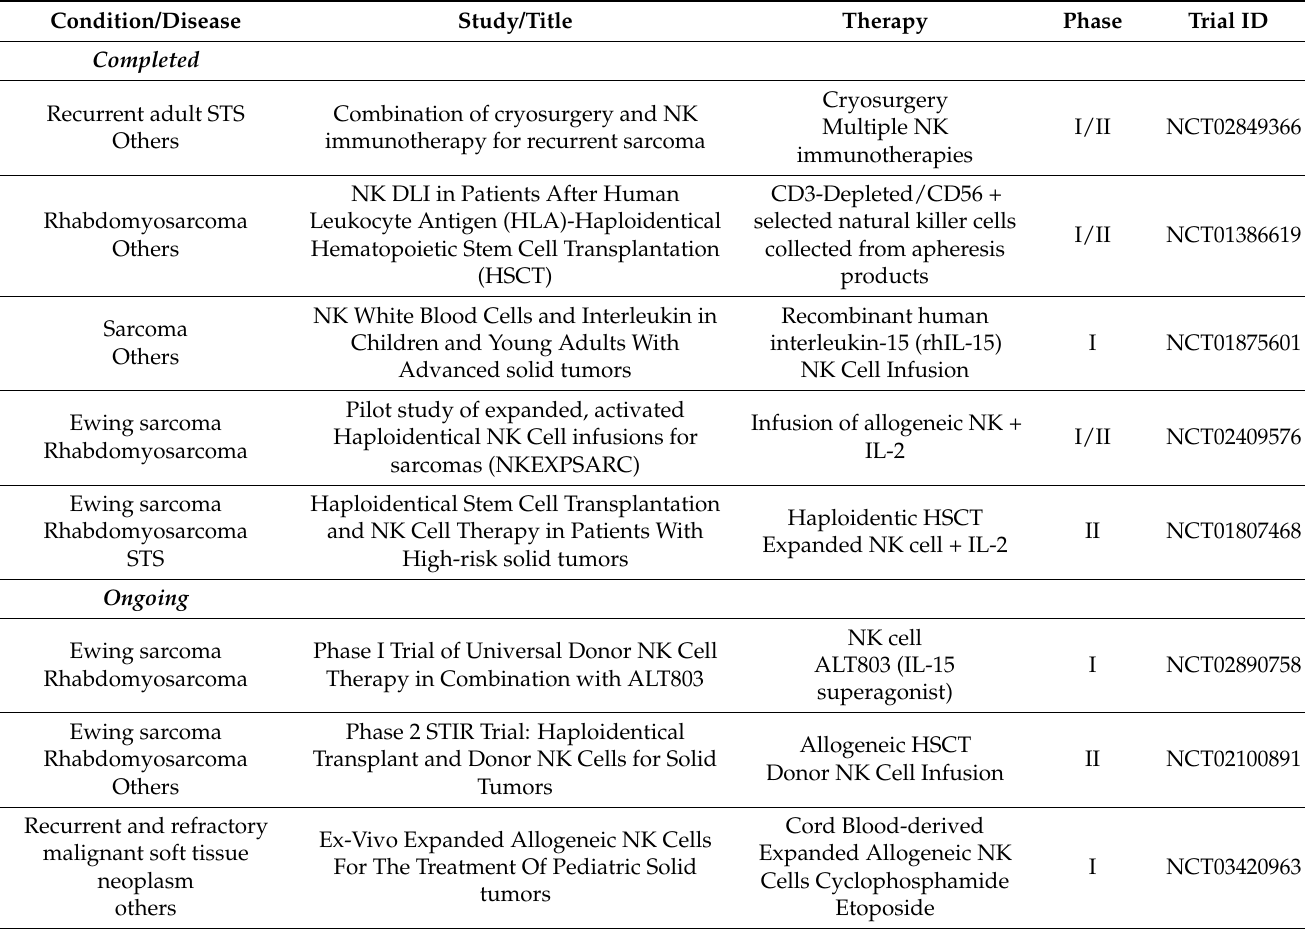
Table 2. Completed and ongoing NK cell-based immunotherapies (ClinicalTrials.org, accessed on 31 May 2021) in soft tissue